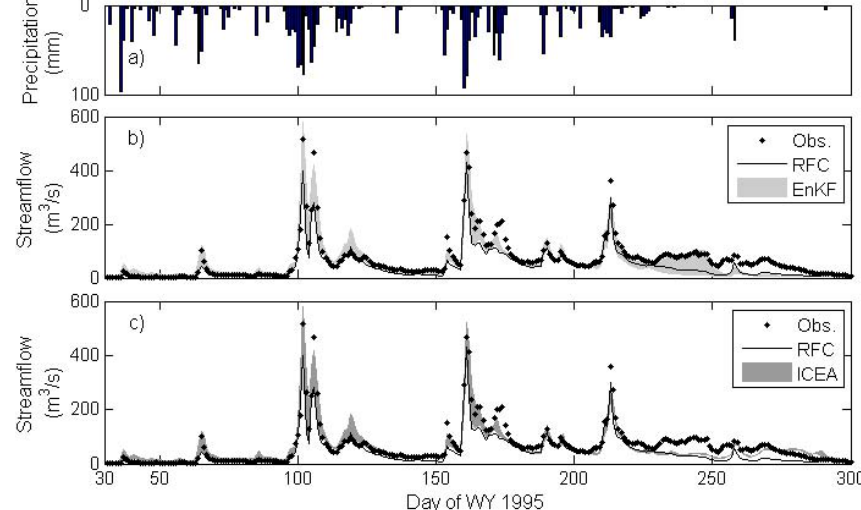
Fig. 9. Basin-average precipitation (a) , ensemble streamflow predictions from the stand-alone EnKF (b) , and ensemble streamflow predic- tions from the ICEA (c) for water year 1995. Also shown are observed streamflow (circles) and RFC streamflow predictions (black line) during the same period. The grey regions correspond to the entire ensemble range.